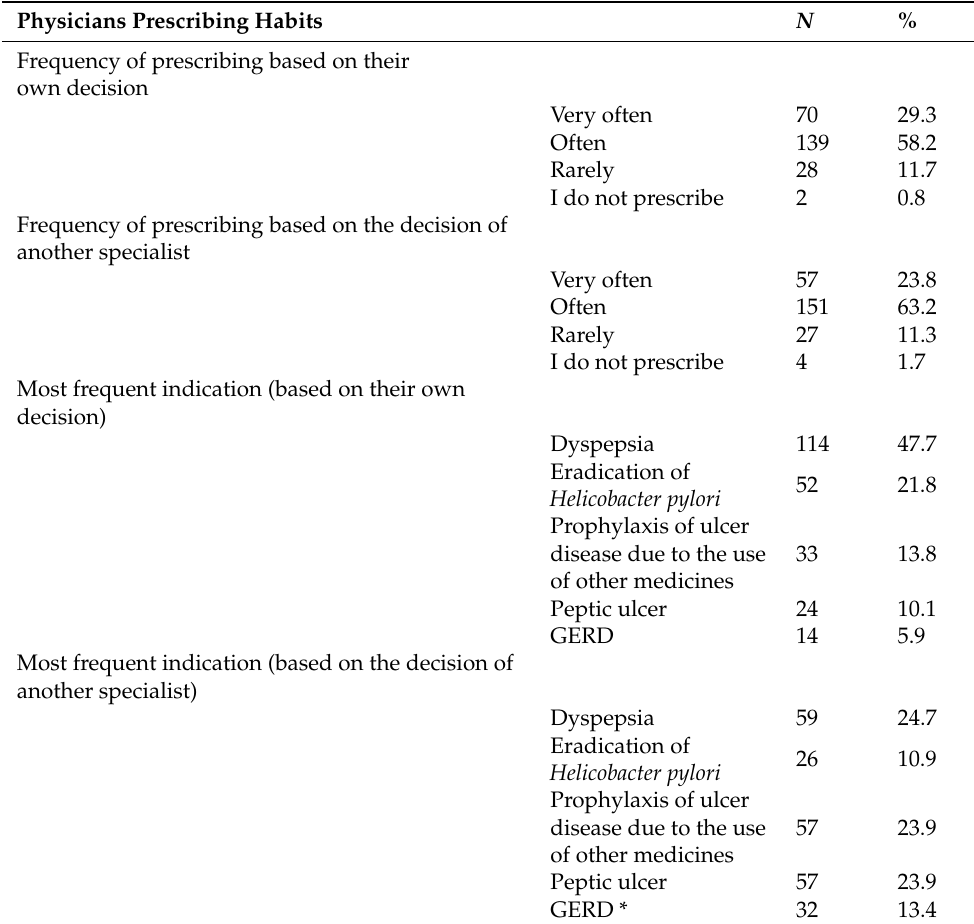
Table 3. Physicians prescribing habits of PPIs ( N =